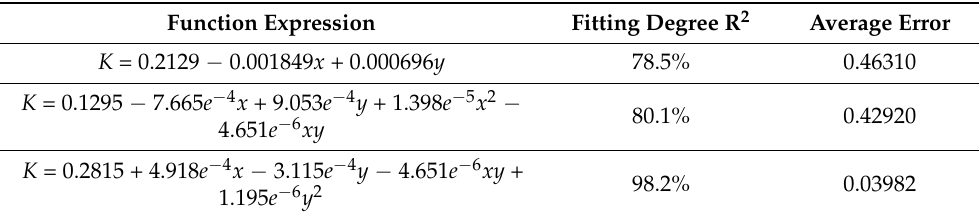
Table 3. Summary of mathematical models for sandstone permeability under temperature-stress